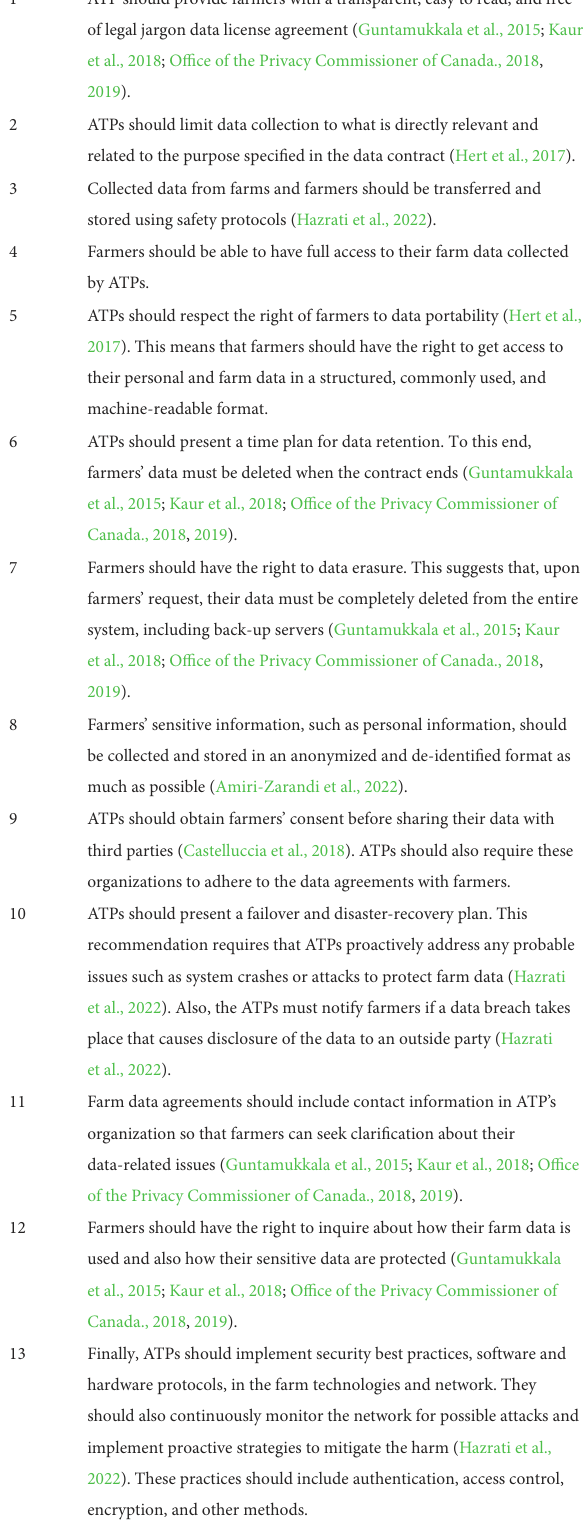
TABLE 2 Recommended data practices for